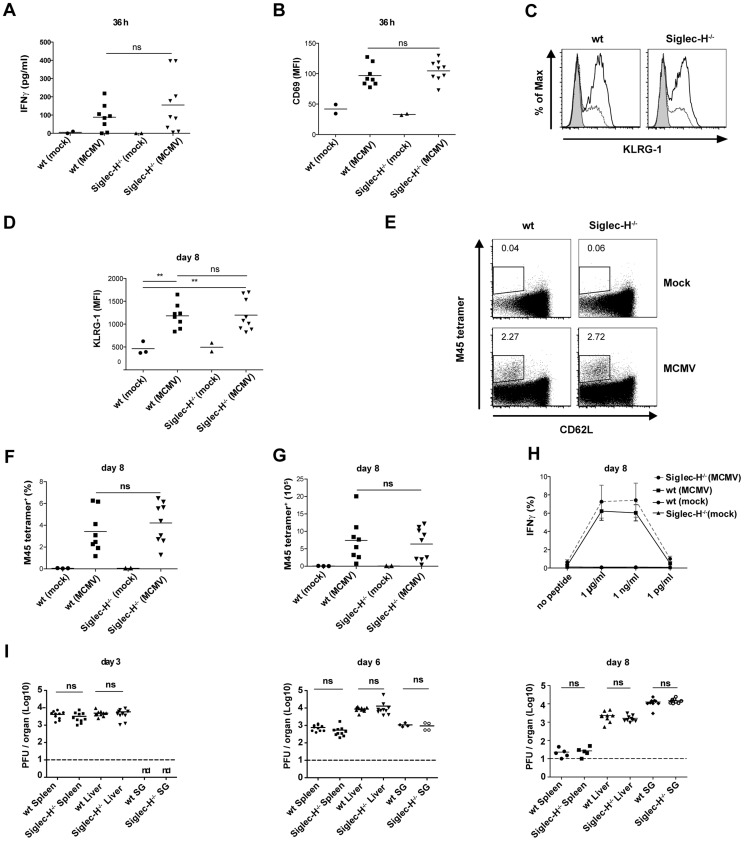
MCMV activates Ly49H+ NK cells and expands Ag-specific CD8+ T cells from Siglec-H−/− and wt mice with similar viral clearance in the primary and secondary organs.Siglec-H−/− and wt chimeric mice were infected with 5×104 PFU of wt MCMV or mock treated with PBS. (A, B) IFNγ serum concentrations were determined at 36 h p.i. and the MFI of CD69 expression on NK1.1+ blood NK cells was quantified by flow cytometry. (C, D) Representative histogram overlays and quantification of KLRG-1 expression on splenic NK1.1+ Ly49H+ cells at day 8 p.i. (E) Representative FACS plots for H-2Db M45 tetramer staining and CD62L expression among CD8+ splenocytes. (F, G) Quantification of frequencies and absolute numbers of tetramer+ CD8+ T cells from the tetramer staining shown in (E). (H) Shows frequencies of IFNγ+ cells among CD8+ T cells after restimulation with the indicated concentrations of H-2Db M45 peptide. (I) Viral load was measured in the spleen, liver and salivary glands of MCMV infected Siglec-H−/− and wt mice at day 3, 6 and 8 p.i. Dashed line indicates the limit of detection. Data shown are pooled from 2–3 individual experiments. **p<0.01 Students t-test, ns = not significant, nd = not detectable.